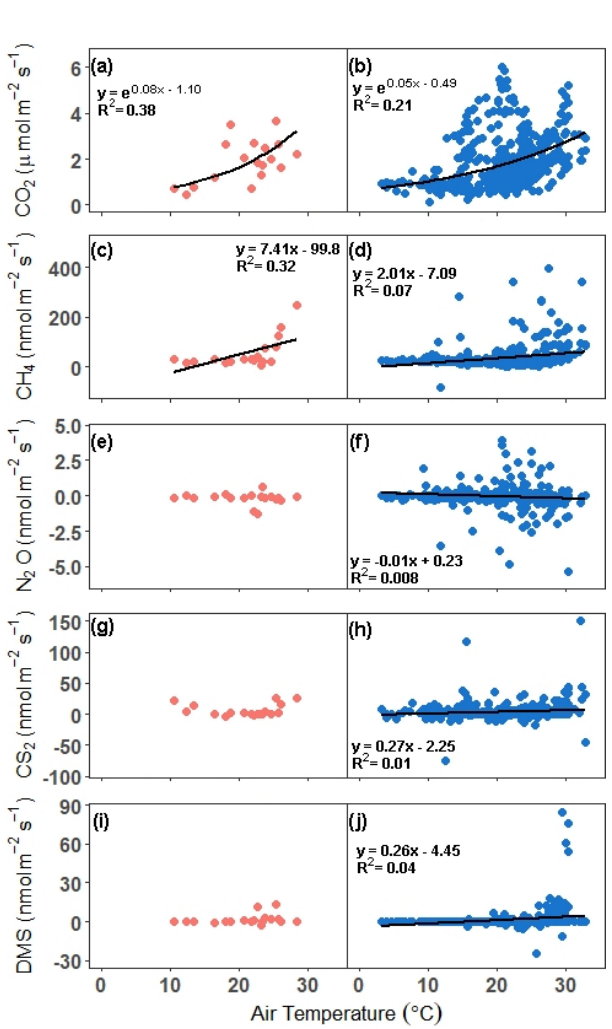
Figure 6. Comparison of fluxes versus air temperature for all cam- paigns. In panels (a) , (c) , (e) , (g), and (i) , the discrete (1h before and 1h after daytime low tide) daily mean is compared with the daily mean air temperature, while in panels (b) , (d) , (f) , (h) , and (j) , the hourly continuous (over ∼ 72h) mean is compared with the hourly air temperature. The trend lines for significant relationships at alpha < 0.05 are plotted. Note that in panel (d) , the outlier hourly mean of 2275nmolm − 2 s − 1 is not included in the trend line or in the